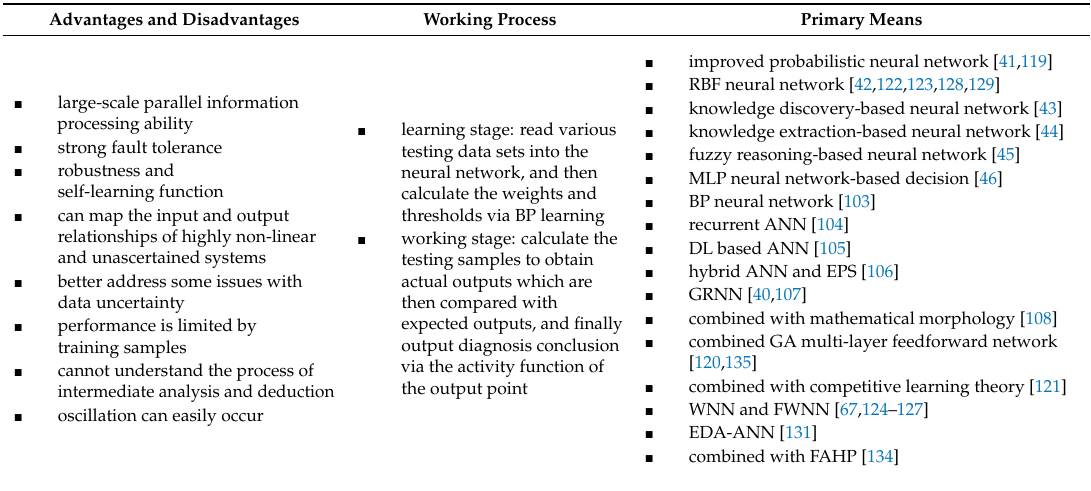
Table 6. A summary for the application of ANN in DGA based transformer fault diagnosis. Advantages and Disadvantages Working Process Primary Means